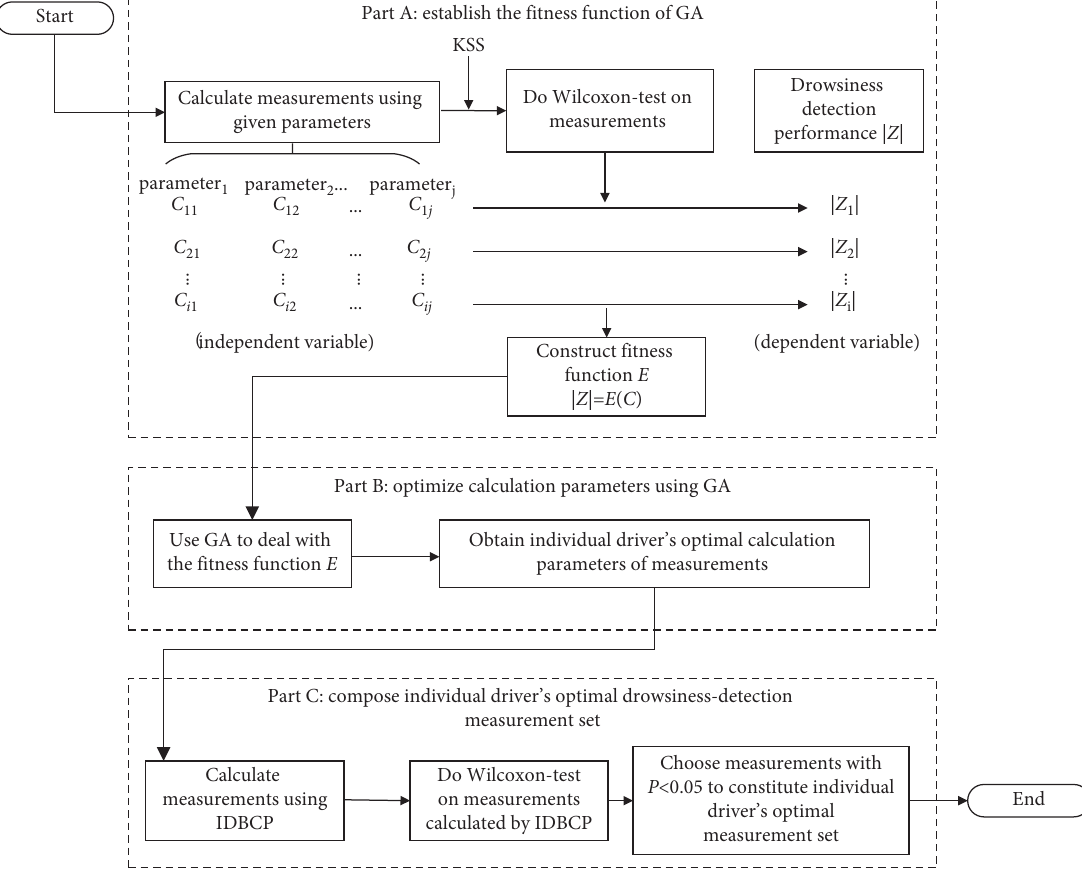
Figure 4: Extraction model of optimal drowsy driving measurements of individual